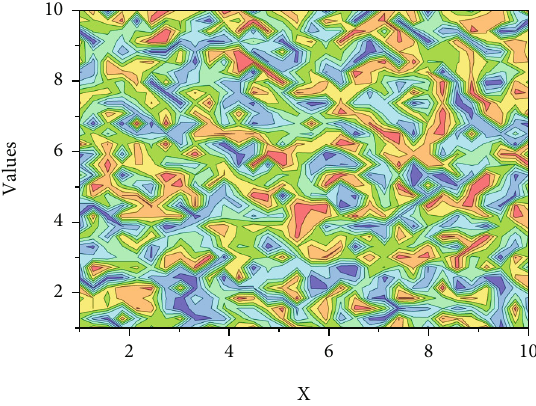
Figure 8: Comparison of computational e ffi